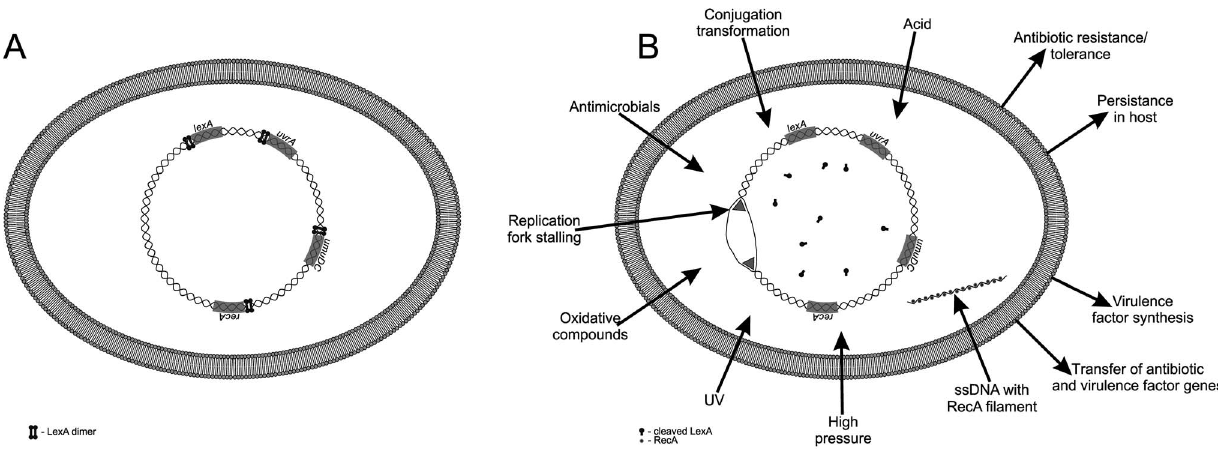
Figure 1. The bacterial SOS response. (A) During normal growth the LexA transcriptional repressor downregulates the SOS response genes. (B) Various endogenous and exogenous triggers induce the SOS response, resulting in drug resistance, tolerance, persistence in host, virulence-factor synthesis, and dissemination of both resistance and virulence factor genes.